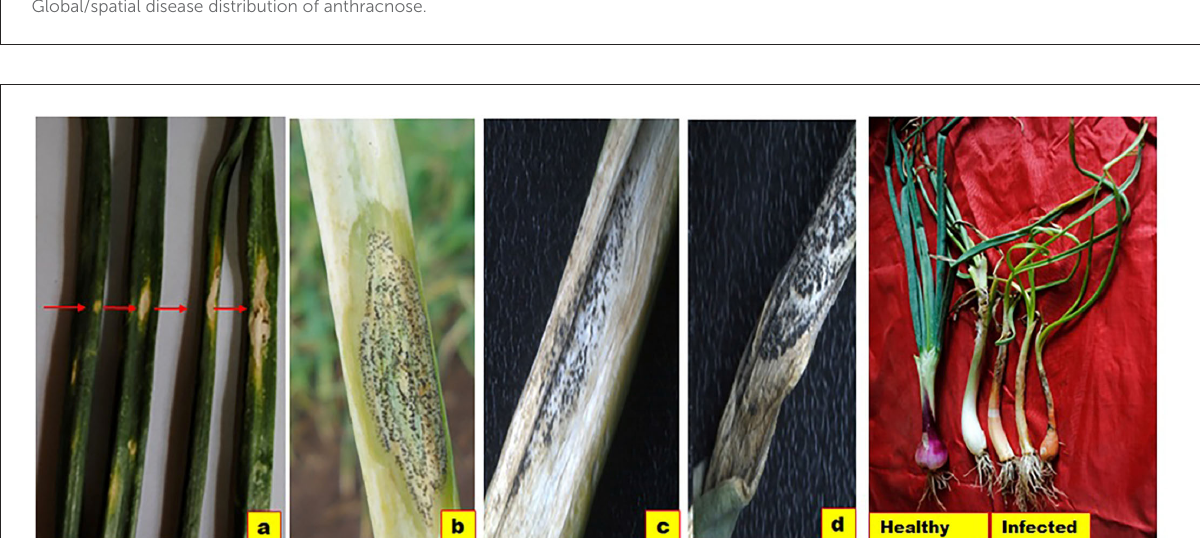
FIGURE2 Global/spatial disease distribution of anthracnose.